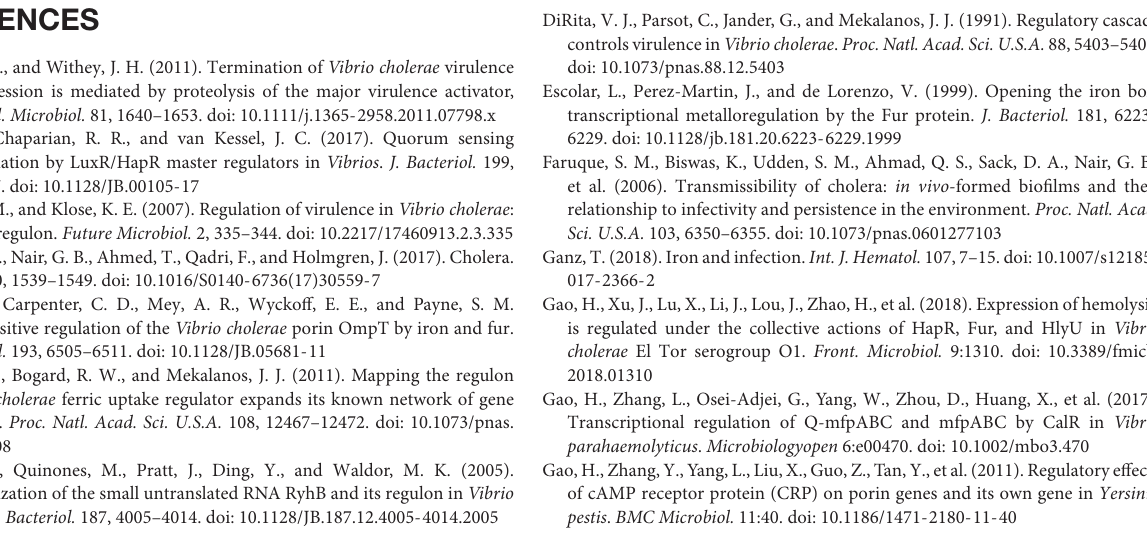
FIGURE S1 | Regulation of toxR by HapR. The qPCR (A) and DNase I footprinting assays were done as in Figure 3 , while the luminescence assay (B) was done as in Figure 2 . L-I, -II, and -III contain 0, 2.31, and 6.92 pmol of His-HapR, respectively. FIGURE S2 | Regulation of toxR by Fur. The qPCR (A) and DNase I footprinting assays were done as Figure 3 , while the luminescence assay (B) was done as in Figure 2 . L-I, -II, and -III contain 0, 2.95, and 8.85 pmol of His-Fur, respectively. FIGURE S3 | The nucleotide sequences alignment of the promoter DNA regions of tcpP and toxT . The promoter DNA sequences of tcpP , toxT and tcpA were derived from V. cholerae El Tor biotype strain C7258 and classical biotype strain O395. The different bases were labeledred, while the identical bases were marked with asterisk (*). Shown also were the transcription start sites, -10 and -35 boxes. FIGURE S4 | Transcription start site of tcpA in V. cholerae El Tor biotype strain C7258. A 5 (cid:48) -HEX-labeled reverse primer was designed to be complementary to the RNA transcript of tcpA . The primer extension products were analyzed with an ABI 3500XL DNA Genetic analyzer. The transcription start site was marked with asterisks